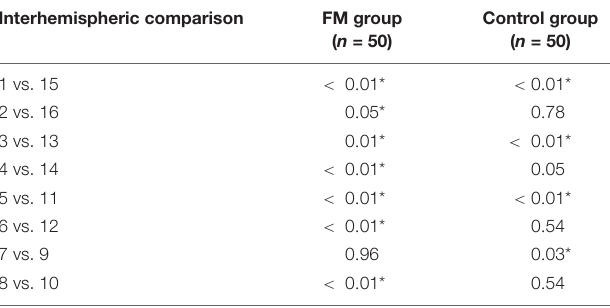
TABLE 3 | p -values representing the level of statistical significance of the difference of mean oxy-hemoglobin concentration between the corresponding pair of fNIRS detectors on the scalp in two study groups, fibromyalgia patients and controls. Interhemispheric comparison FM group ( n = 50)